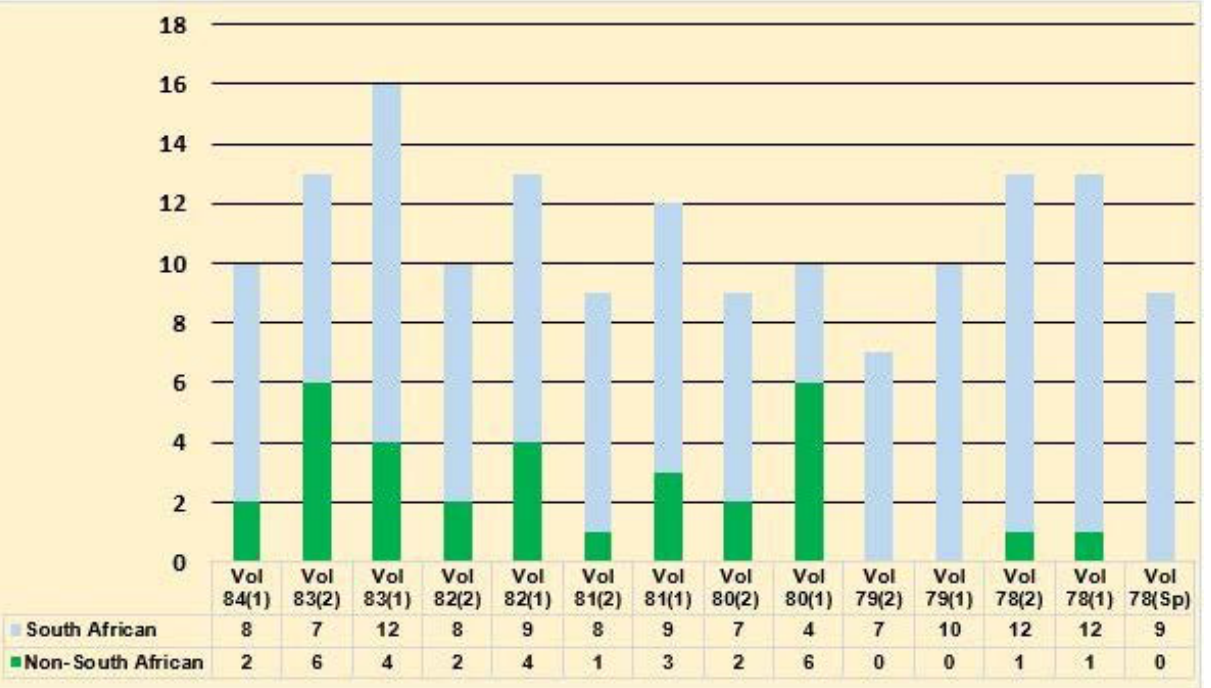
Figure 1: Number of published articles in South African Journal of Libraries and Information Science by South African affiliated and non-South African affiliated